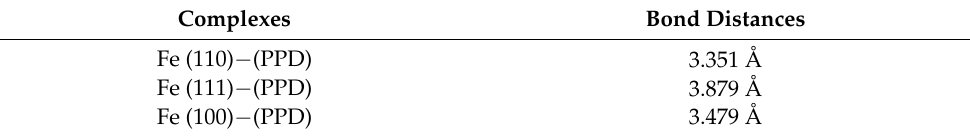
Table 8. The bond distance for {PPD/Fe (100), Fe (110) and Fe (111)} interfaces. Complexes